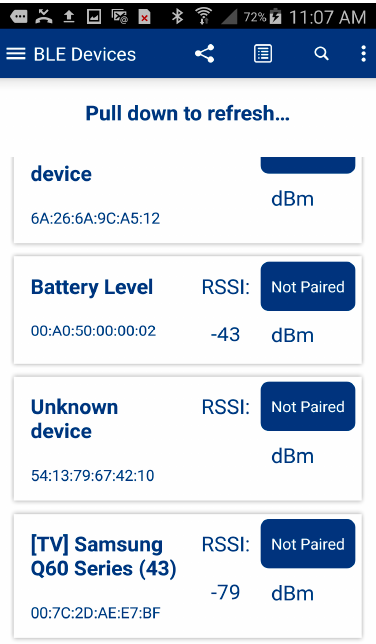
Figure 15. CySmart Scan Results for Connected Devices.